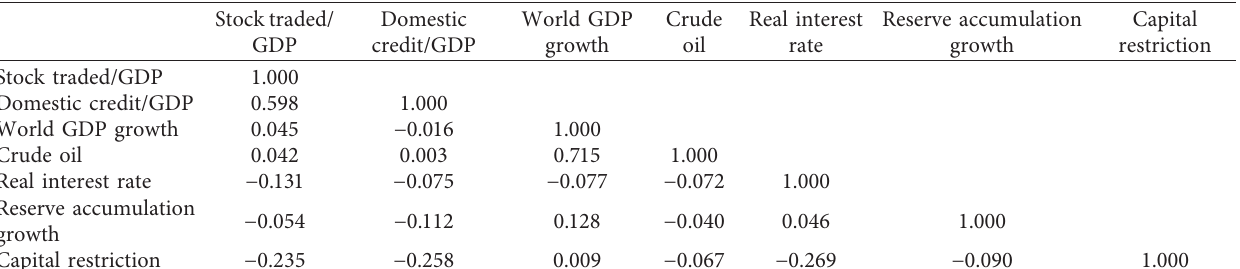
Figure 3: Capital flows between the U.S. and five regions. Sources: The U.S. FDI inflow and outflows are collected from IMF World Economic Outlook. Table 3: Correlation